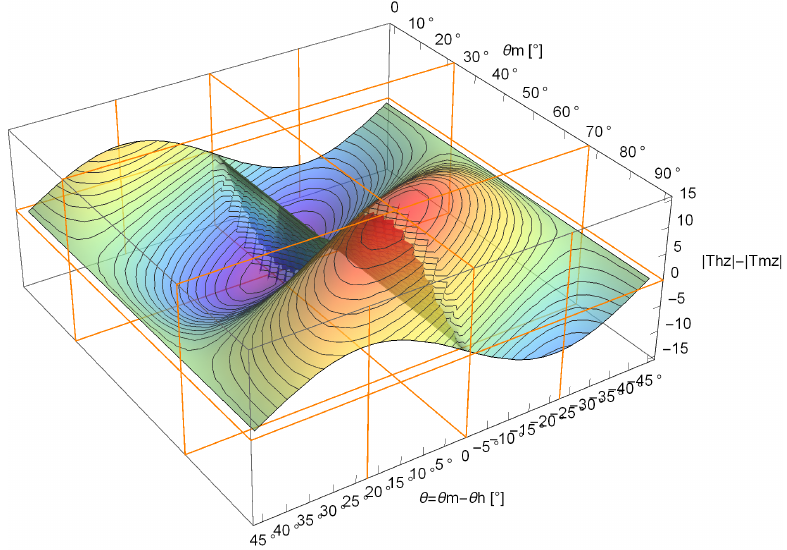
Figure 13. Torques absolute difference | Th z | − | Tm z | [ mNm ] for α max in function of θ and θ m